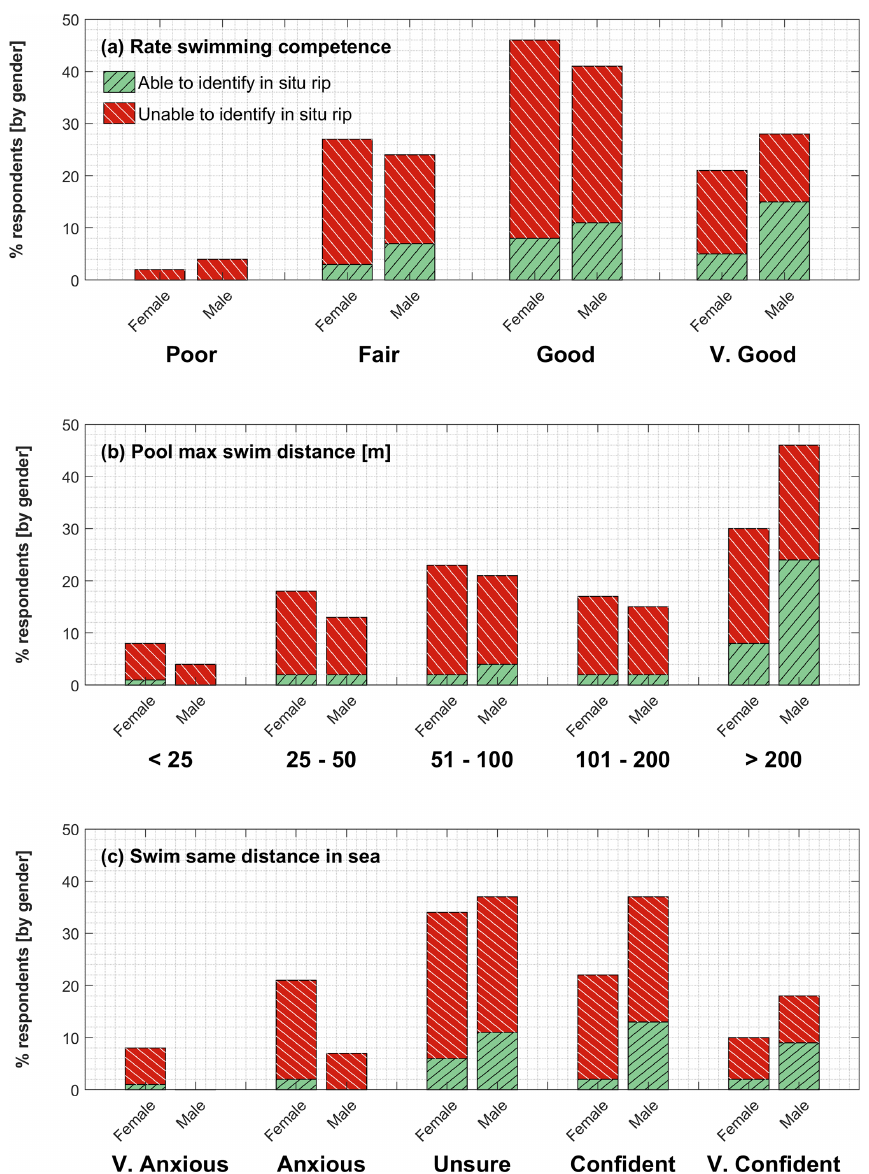
Figure 4. Respondents’ ability to identify the in situ rip current as a function of (a) their self-reported swimming competence, (b) the maximum distance they reported being able to swim in a pool non-stop, and (c) their feeling at being asked to swim the same distance in the sea. Responses are broken down by gender, with green bars indicative of the percentage of respondents able to identify the in situ rip and red bars indicative of those who